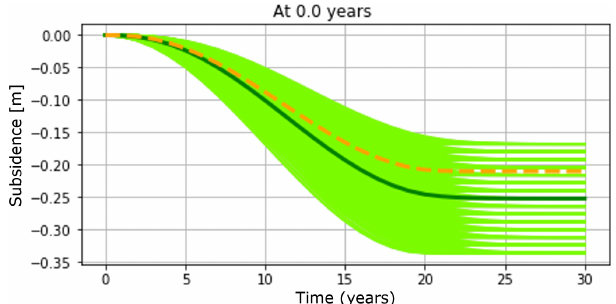
Figure 6. The a priori ensemble of possible subsidence scenarios (green lines), given an initial uncertainty in the value of the deepest point, and in the time path towards this value (given different values for a possible time-delay coefficient). The “true” scenario is plotted as an orange dashed line, the mean of the ensemble (or best a priori estimate) as a black line.